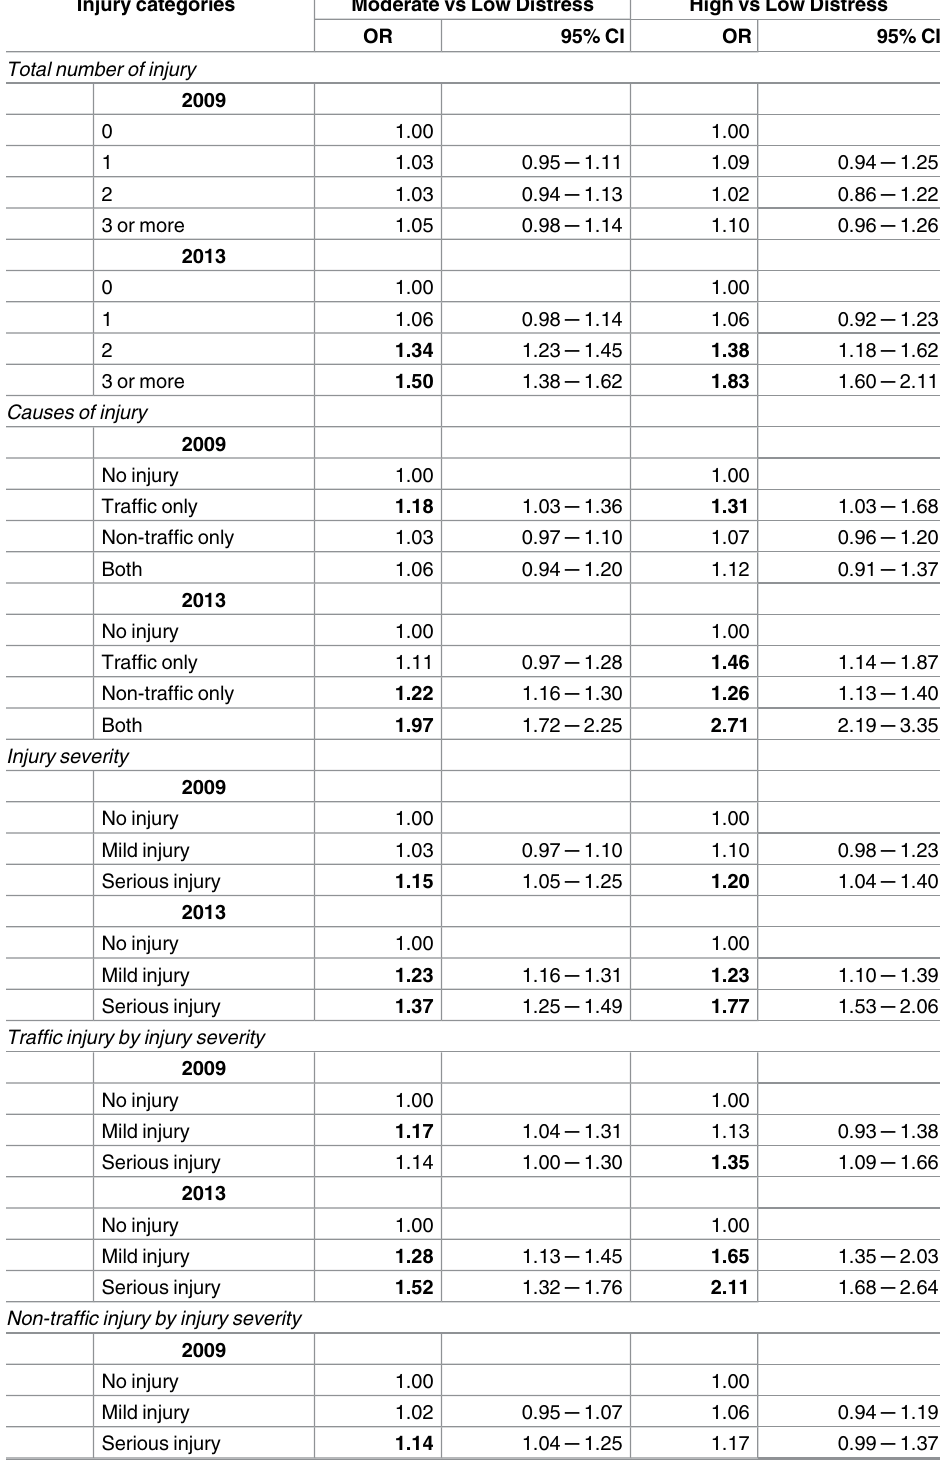
Table 3. Adjusted association between different injury categories and psychological distress, using multinomial logistic regression